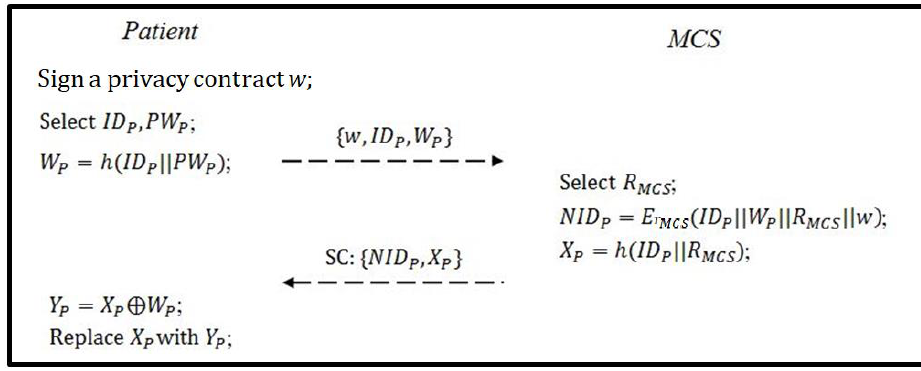
Figure 2. The processes of registration phase of the proposed scheme.